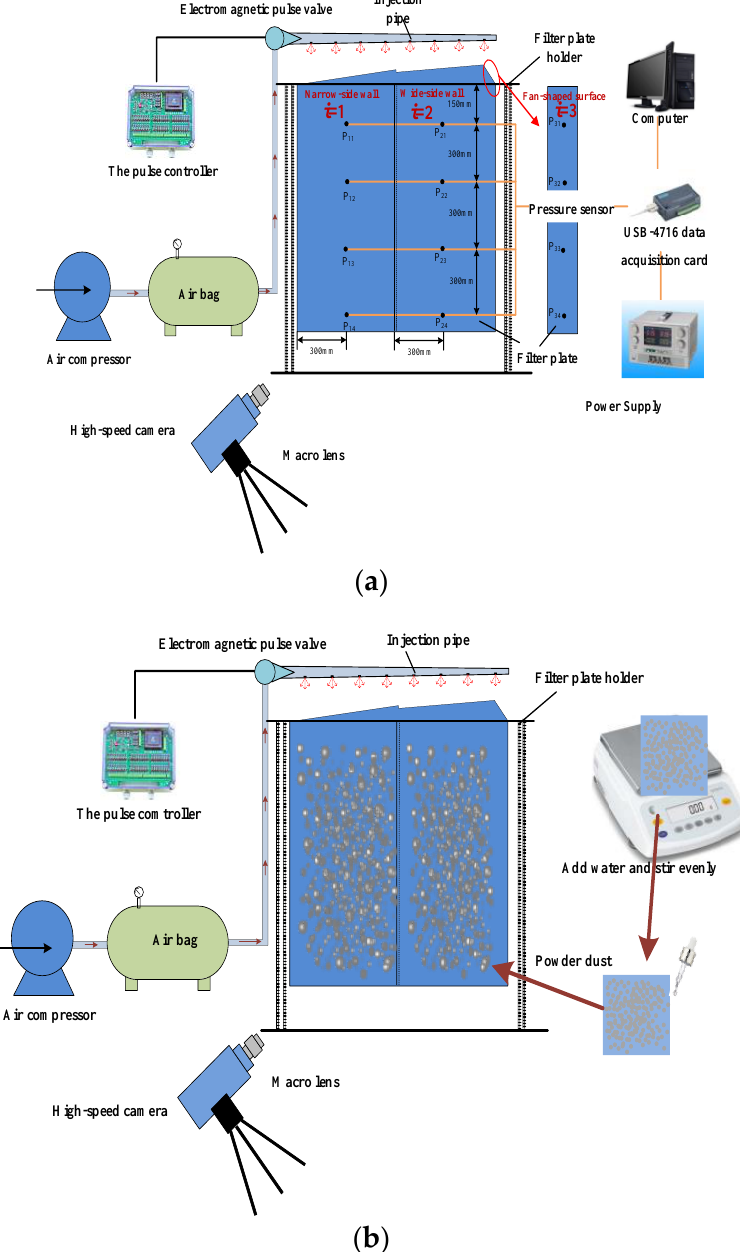
Figure 1. Experimental device for the dust cleaning performance of the NSMMFP ( a ) The experimen- tal device diagram and system schematic diagram of the wall surface peak pressure test. ( b ) The powder-attached experimental device diagram and principal